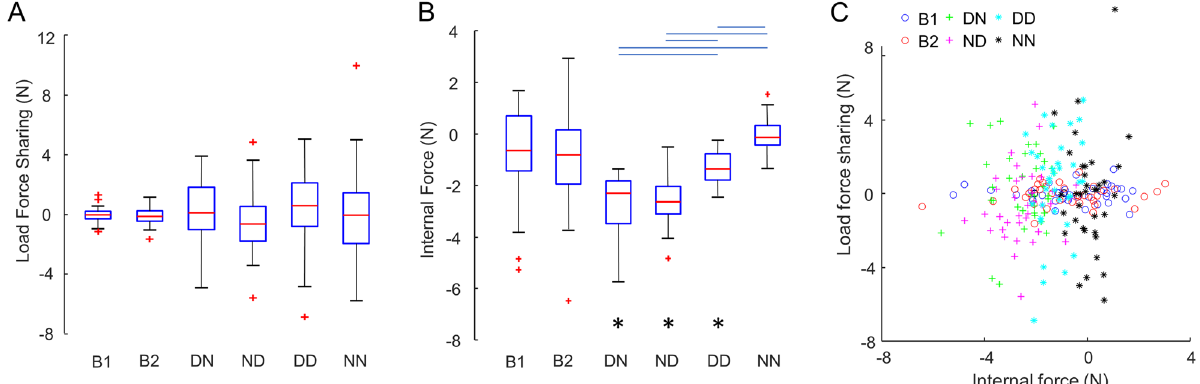
Figure 2. Force coordination in object balancing tasks. ( A ) Sharing of load forces between two handles. Boxplots show median values as red lines, with 25 and 75 percentiles depicted as blue boxes. The whiskers extend to most extreme points that are not potential outliers (i.e., red crosses). ( B ) Internal force. Conditions joined by the two ends of the blue horizontal lines are statistically different. The bottom asterisks represent significanct difference from zero. ( C ) Distribution of force coordination strategies. Each data point represents the average force pattern of a participant (bimanual conditions) or a dyad (dyadic